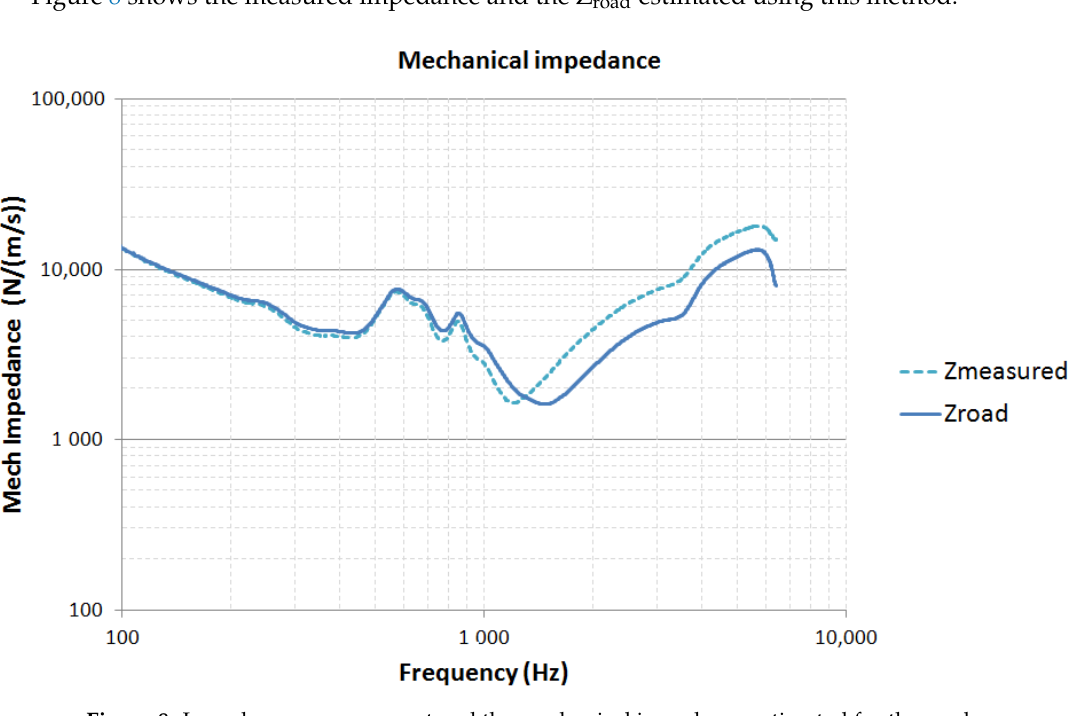
Figure 7. Mechanical impedance scheme.